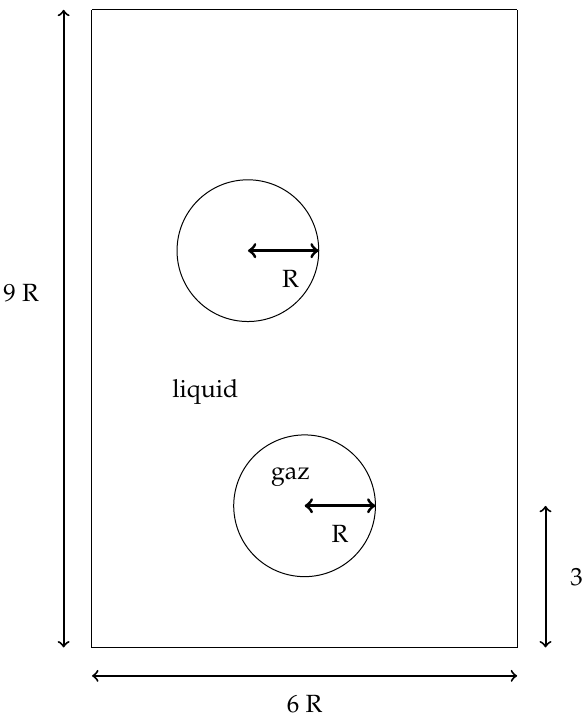
Figure 12. Initial fluid domain for the test case of the two rising bubbles in water. In Figure 13, the interface evolution and the vorticity values for the Ghost Fluid method (used for the pressure computation) and the new method are plotted. One observes small oscillations of the vorticity near the interface between two fluids for the Ghost Fluid method, but not for the new method. The conservation of the partial mass of air and momentum of air in each dimension for the new method, and the Ghost Fluid method are depicted in Figures 14–16 respectively. As air is the less dense fluid, it is more prone to big oscillations if erroneous mass and momentum transfers between the two fluids occur. One can observe that with the new method and its second-order pressure resolution, the oscillations of these quantities are notably less present than for the Ghost Fluid. The partial mass is better conserved too.